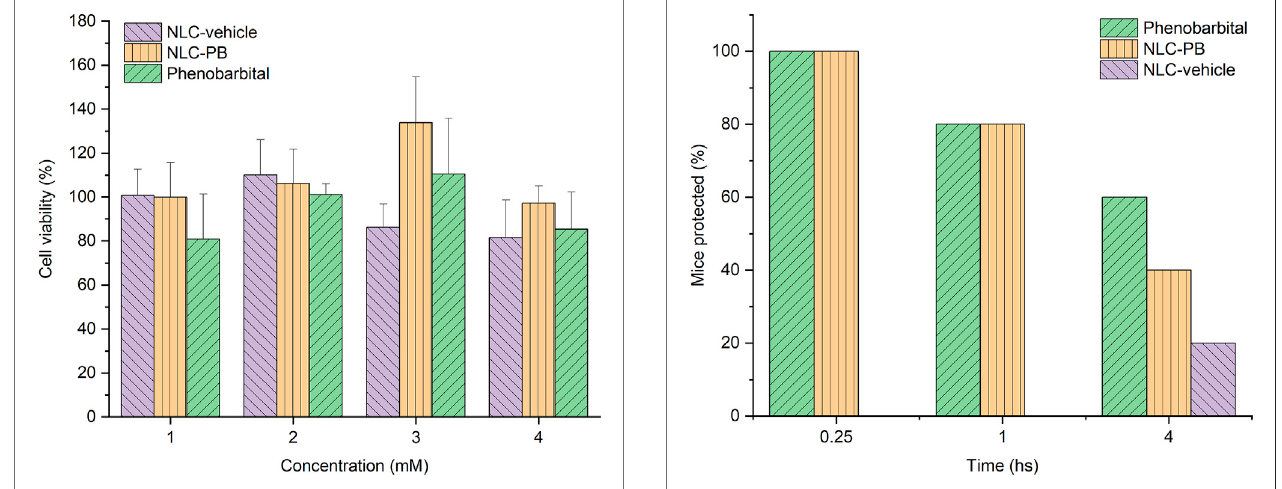
FIGURE 9 | Cell viability analysis by MTT assay. L929 cells were treated with different concentrations (1 – 4 mM) of NLC-PB, NLC-vehicle, and PB.